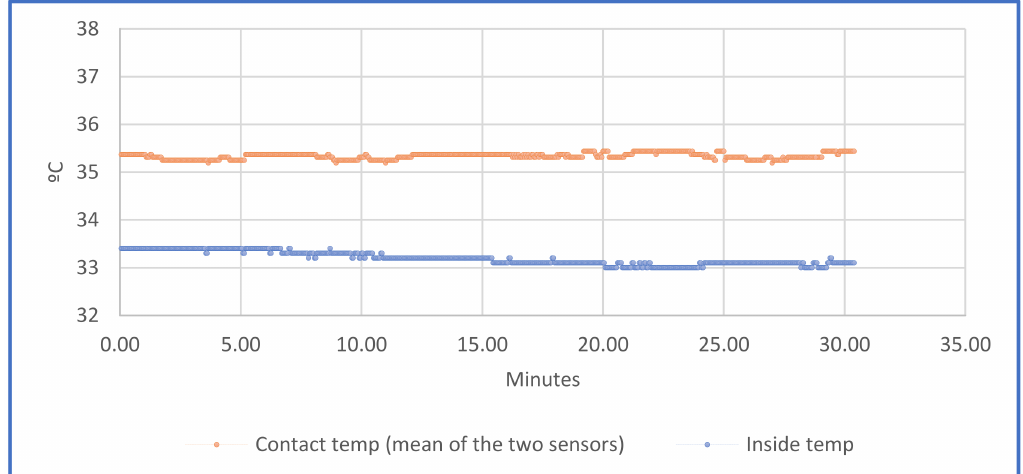
Figure 15. Temperature’s graph.